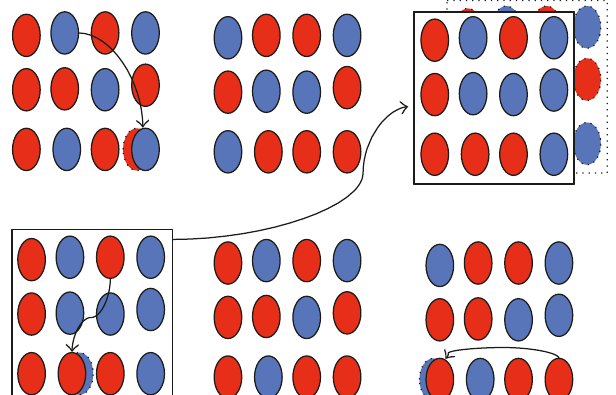
Figure 1: Two-Level Moran Process . This is a condensed representation of the two-level, discrete time Moran process in our model. Each isolated cluster of red and blue ovals is a “group,” while the ovals themselves are “individuals,” which come in two varieties, cooperators (blue) anddefectors (red). Thesetofsix groupsconstitutesa metapopulation. Within a group, an individual ischosen to reproduceand replace some individual in the same group: the arrow represents an individual having an identical offspring, which replaces another individual in the group. (The replaced individual has a dashed border around it.) Across groups, a group is chosen to reproduce and replace some group in the metapopulation. The group in the bottom-left corner reproduces and replaces the group in the top-right corner. (The replaced group has a dashed border around